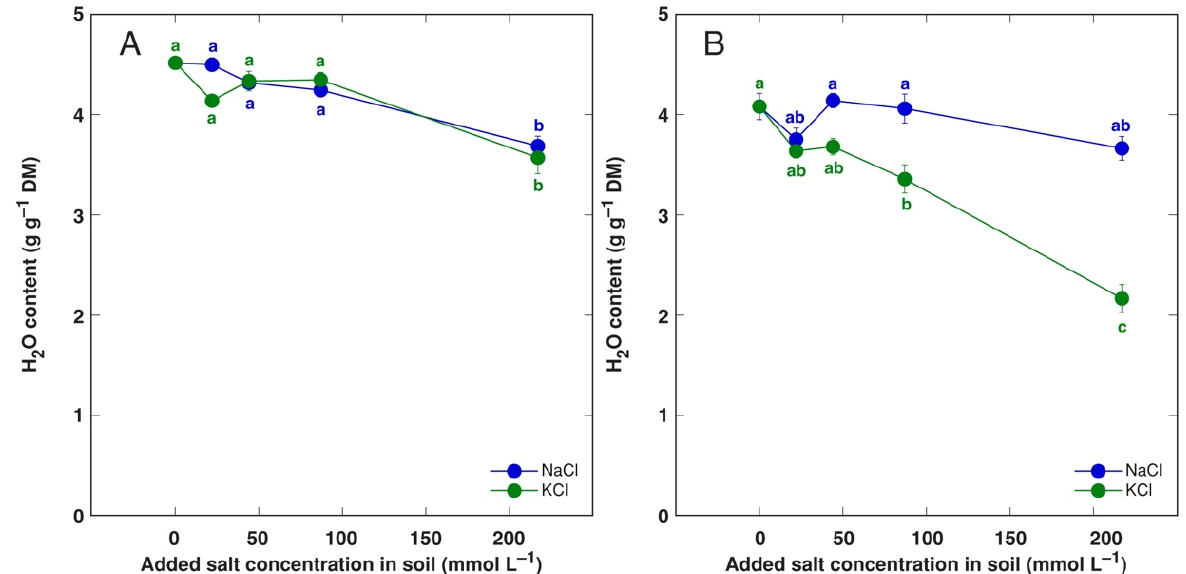
Figure 4. Effect of added NaCl and KCl concentration in soil on water content in old leaves of Armeria maritima plants from accessions AM1 ( A ) and AM2 ( B ) after 8 weeks of cultivation. DM, dry mass. Data are means ± SE from 5 replicates. Different letters of respective color between accessions and treatments indicate statistically significant differences ( p < 0.05).